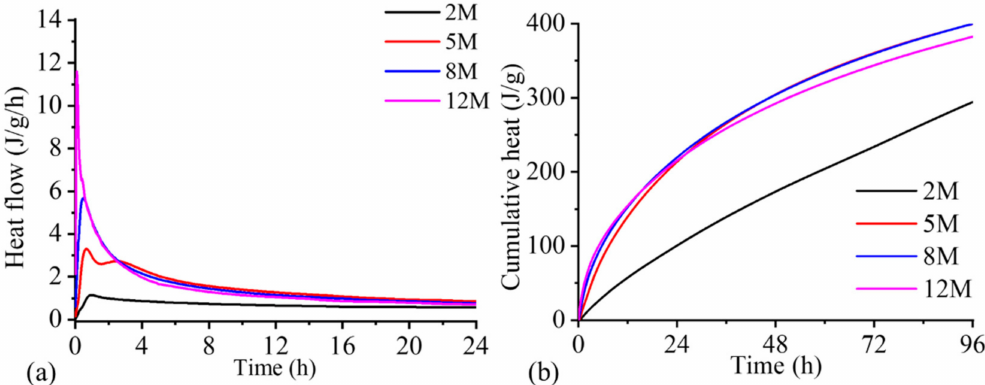
Figure 5. Isothermal calorimetry curves for paste: ( a ) heat flow and ( b ) cumulative